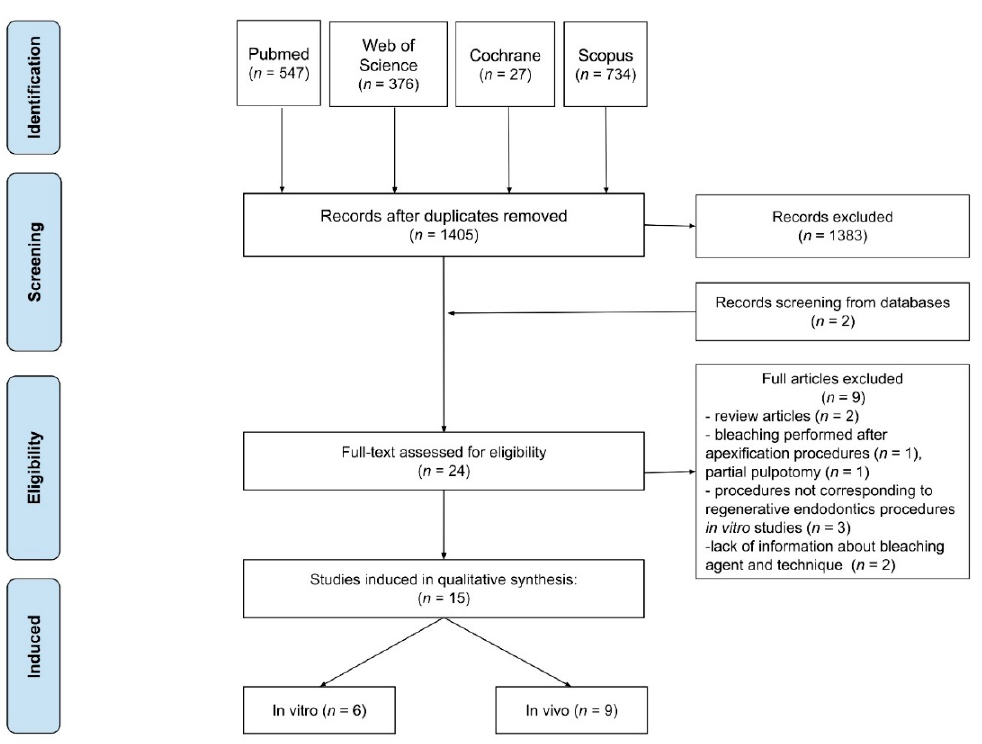
Figure 1. Preferred Reporting Items for Systematic Reviews and Meta-analyses (PRISMA) flow diagram of the search strategy.